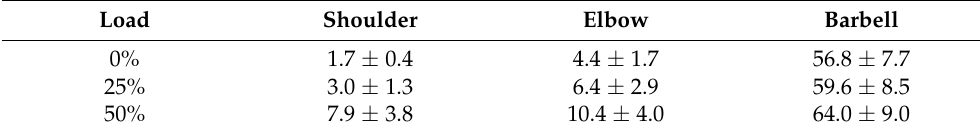
Table 1. Mean maximal values achieved for each marker at the end of the trajectory (shoulder, elbow ( ∆ d), and barbell ( ∆ y)) for the three different loads